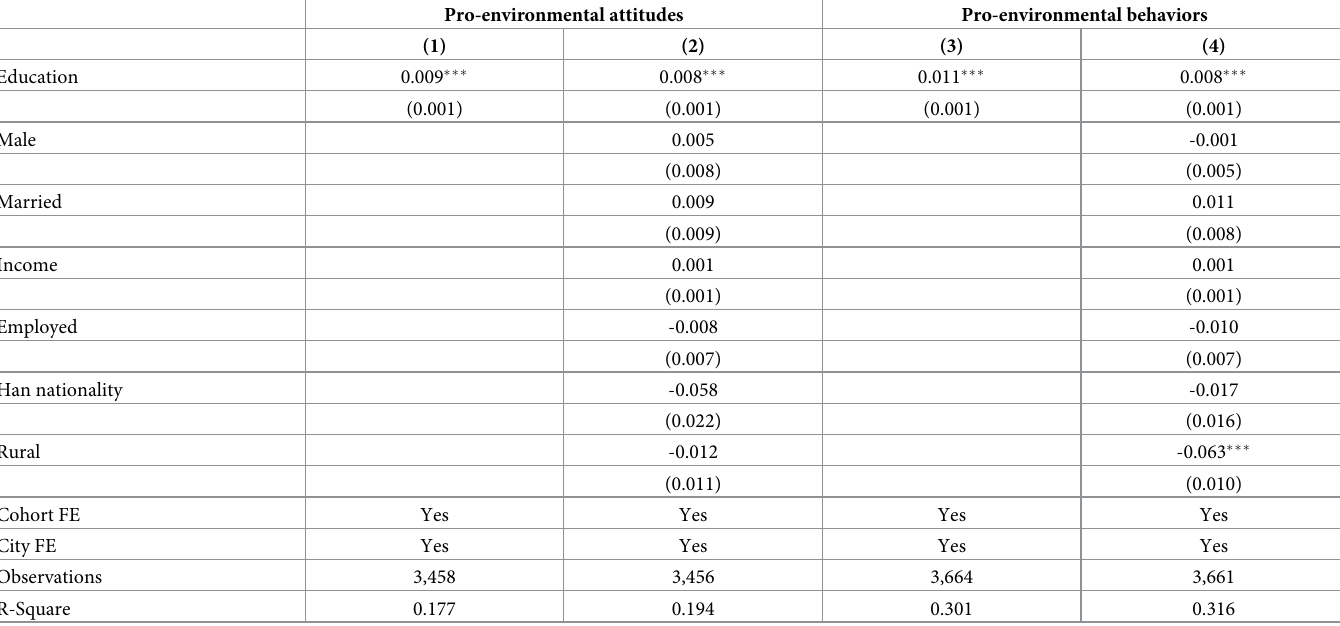
Table 3. The effects of education on pro-environmental attitudes and behaviors, baseline